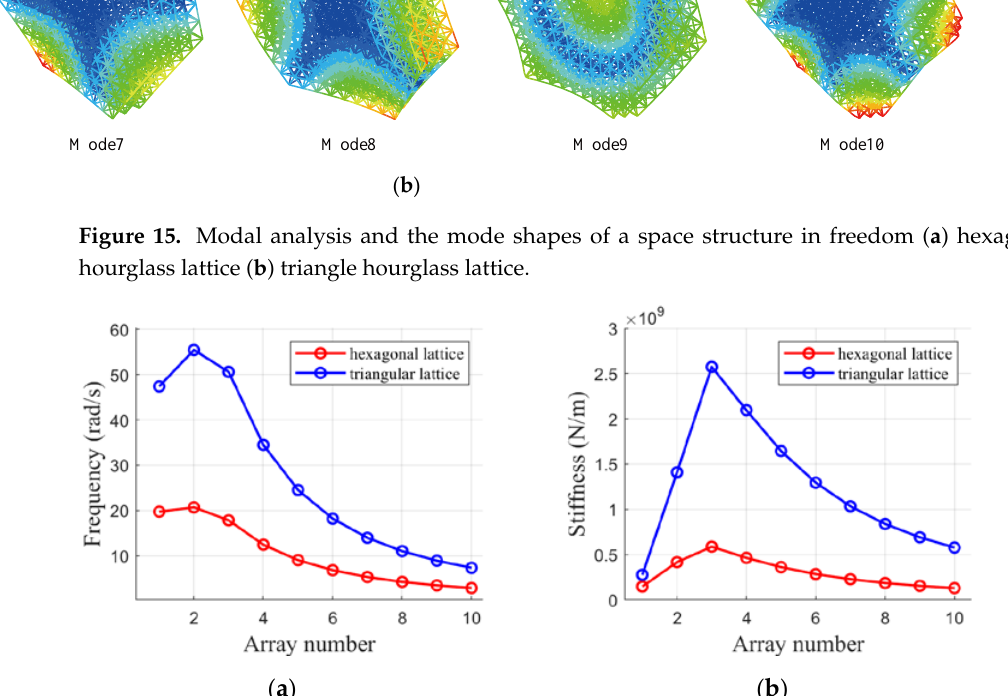
Figure 16. Natural frequency variation with respect to array numbers ( a ) frequency curve ( b ) stiffness curve.